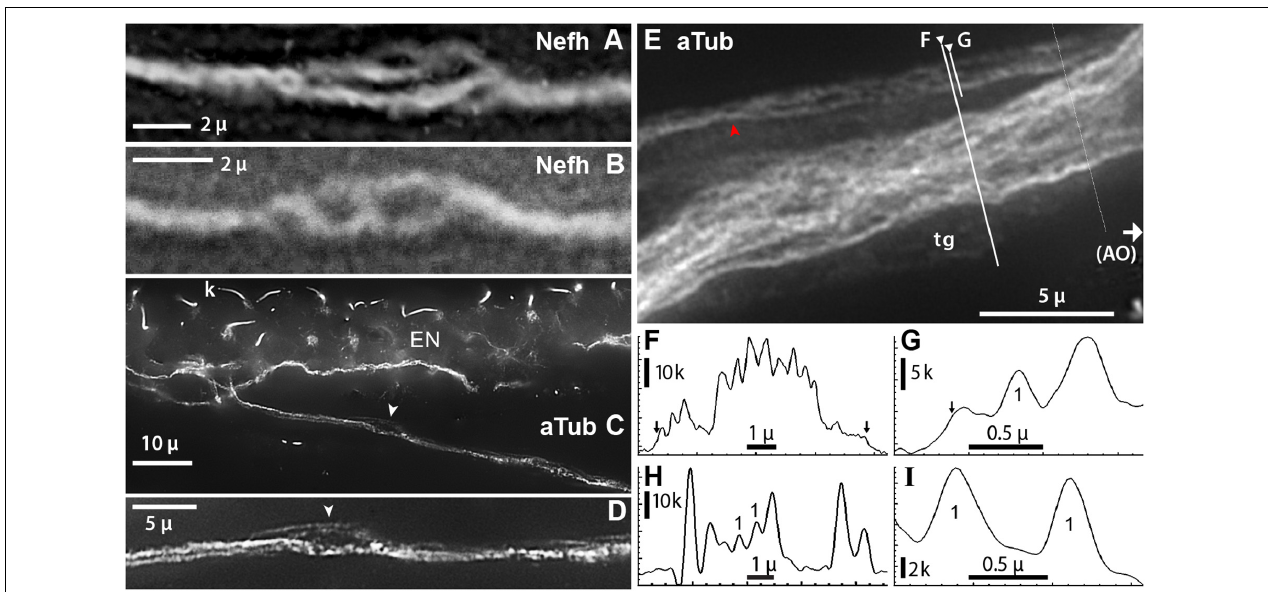
FIGURE 8 | Projection fibers and neurites were labeled by anti–acetylated α -tubulin (aTub, blue emission) or anti–neurofilament-H (Nefh). (A,B) Inline sites on projection fibers where neurites separated. (A) Enlarged image of a site along one projection fiber, corresponding to arrow in Figure 7B , which locally gave rise to four to six smaller-diameter neurites; 40x 0.7 NA lens. (B) This site along a projection fiber exposed two smaller-diameter strands; 40x 0.7 NA lens. (C,D) A fascicle near an electrosensory neuroepithelium (EN), separated locally to reveal unitary neurites ( arrowhead, D ); 60x 1.4 NA lens, 0.25 µ steps. Kinocilia (k) on receptor cells were also labeled by anti–aTub. (E) A condensed fascicle near an ampullary organ (AO) was accompanied by an individual projection fiber ( (cid:74) ) which separated into parallel neurites; 100x 1.25 NA lens, 0.25 µ steps. A terminal glia (tg) sheath surrounded these fascicles; its edges correspond to arrows in (F,G). (F,G) Profile plots of fluorescence intensity along lines across projection fascicles, identified on (E) ; plots started at (cid:74) . (G–I) Profile plots showed small peaks attributed to unitary neurites (“1”). (H) Profile plot along the green line in Figure 7E ; 40x 0.75 NA water lens. (I) Profile plot across two small neurites in another image; 60x 1.4 NA lens. The widths of these two peaks, measured near their base at 15% of peak height above extrapolated baseline, were 0.41, 0.35 µ . (C–I) From 16-bit monochrome images of blue fluorescence. k, x1000 pixel